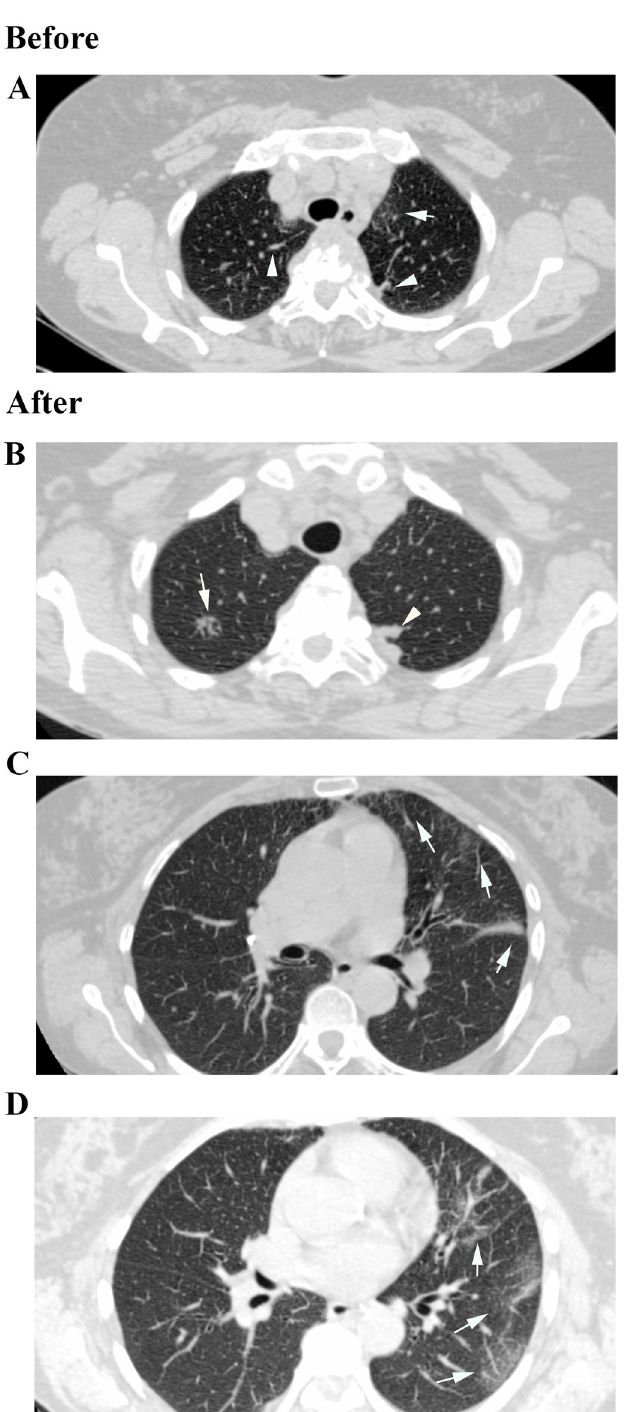
Fig 5. Chest HRCT of a 45 year-old woman (2014–2019). Woman, 45 years. (A) Before: Bronchiectasis (Arrows) and Centrilobular nodules (Arrowheads); (B) After: Centrilobular nodules (Arrow) and Pleural thickening (Arrowhead); (C) After: Ground-glass opacities (Arrows); (D) After: Ground-glass opacities (Arrows).